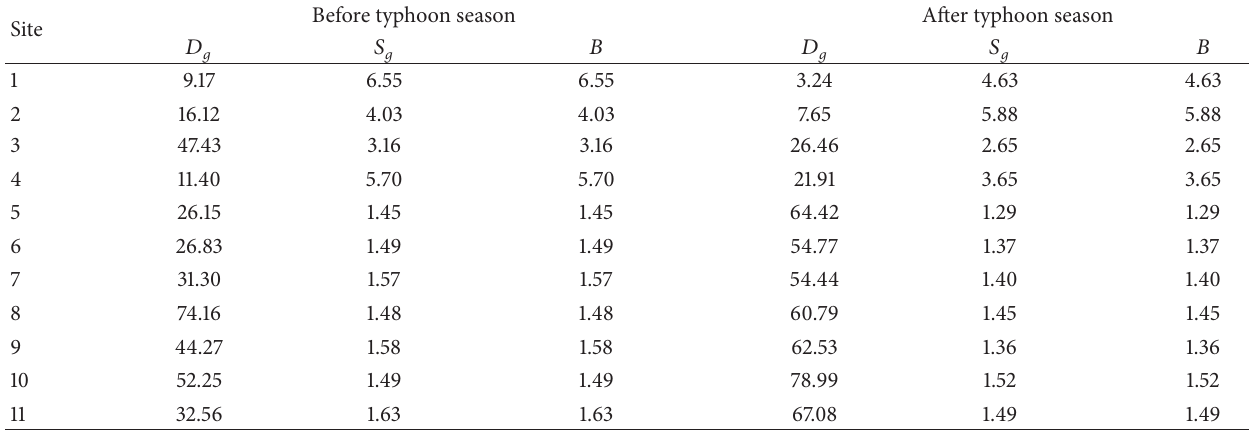
Figure 9: Histograms representing the grain size distributions for grid sampling (NB: 𝐷 (mm) = 2 −Φ ). Table 2: Statistical parameters of size distribution before and after typhoon